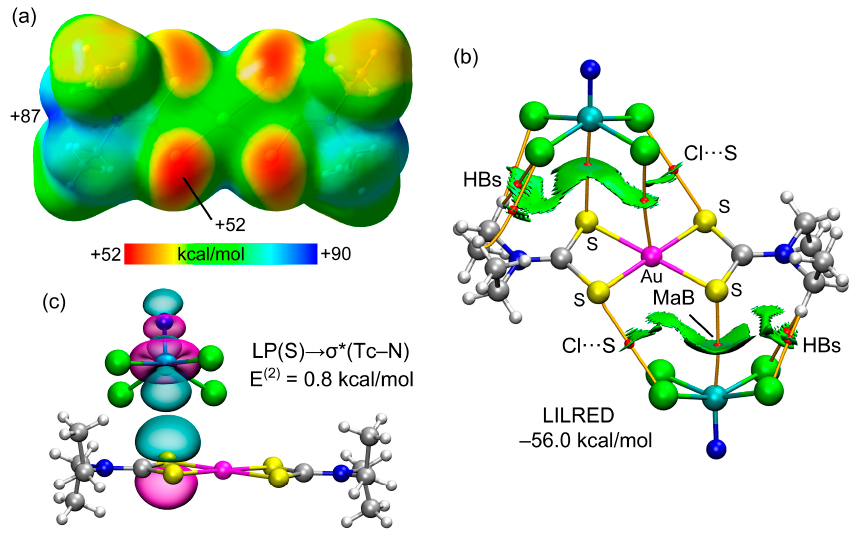
Figure 6. ( a ) MEP surface of cationic part bis ( N , N -diethyldithiocarbamato)-gold(III) (isosurface 0.001 a.u.). Energies at selected points in kcal/mol. ( b ) QTAIM/NCIPlot analysis of the trimer of LILRED with indication of the interaction energy. ( c ) Plot of the NBOs involved in the donor–acceptor interaction of a dimer of LILRED with indication of the E (2) energy. Color code: Carbon grey, Chlorine green, Nitrogen blue, Technetium teal, Gold pink, Sulfur yellow, Hydrogen light grey.